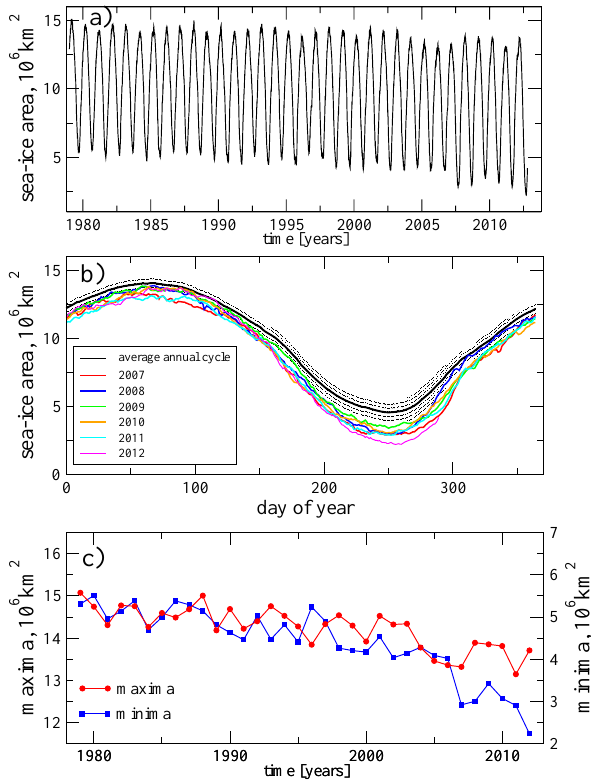
Fig. 1. Arctic sea-ice area from satellite data. (a) Arctic sea-ice area, 1979–2012. (b) The mean annual cycle of the area data over 1979–2008 inclusive (solid line, shaded area denotes two error bars), together with the last five anomalous years. (c) Annual max- ima (left axis) and minima (right axis) showing an abrupt increase in amplitude of the seasonal cycle in